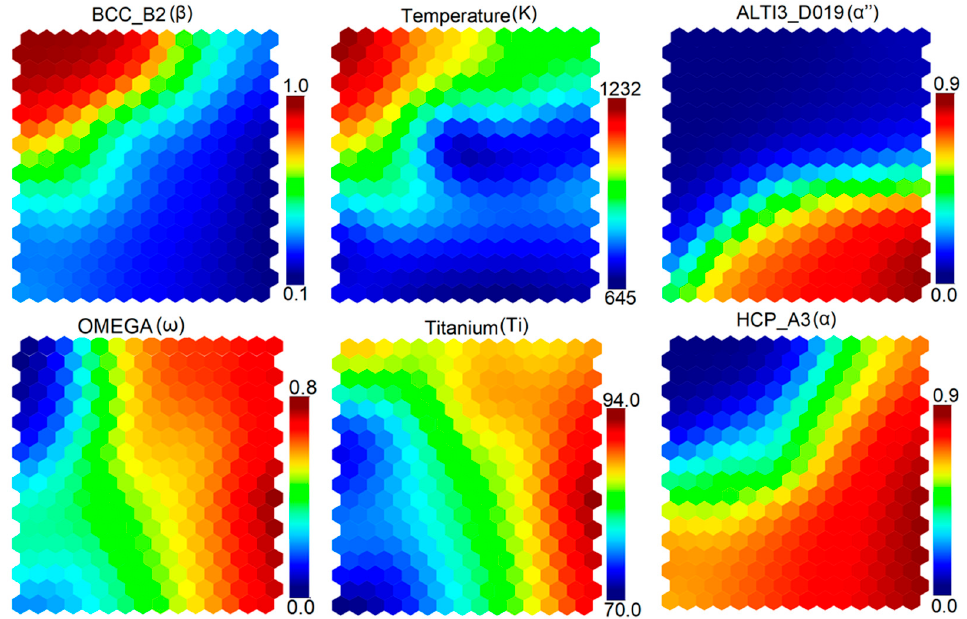
Figure 4. SOM plot showing composition (Ti), temperature and resulting stable and metastable phases for the Ti-Nb-Zr-Sn system. phases for the Ti-Nb-Zr-Sn